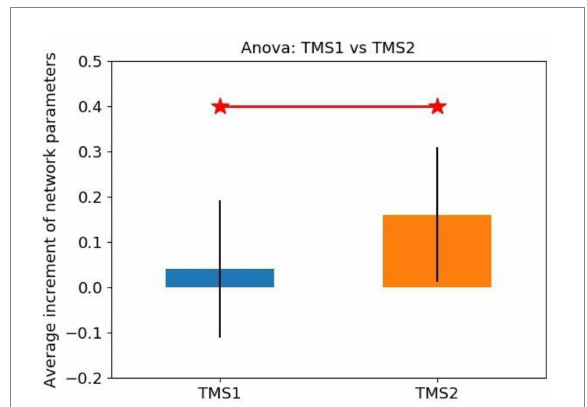
FIGURE 11 Statistical analysis of the average increment of network parameters.